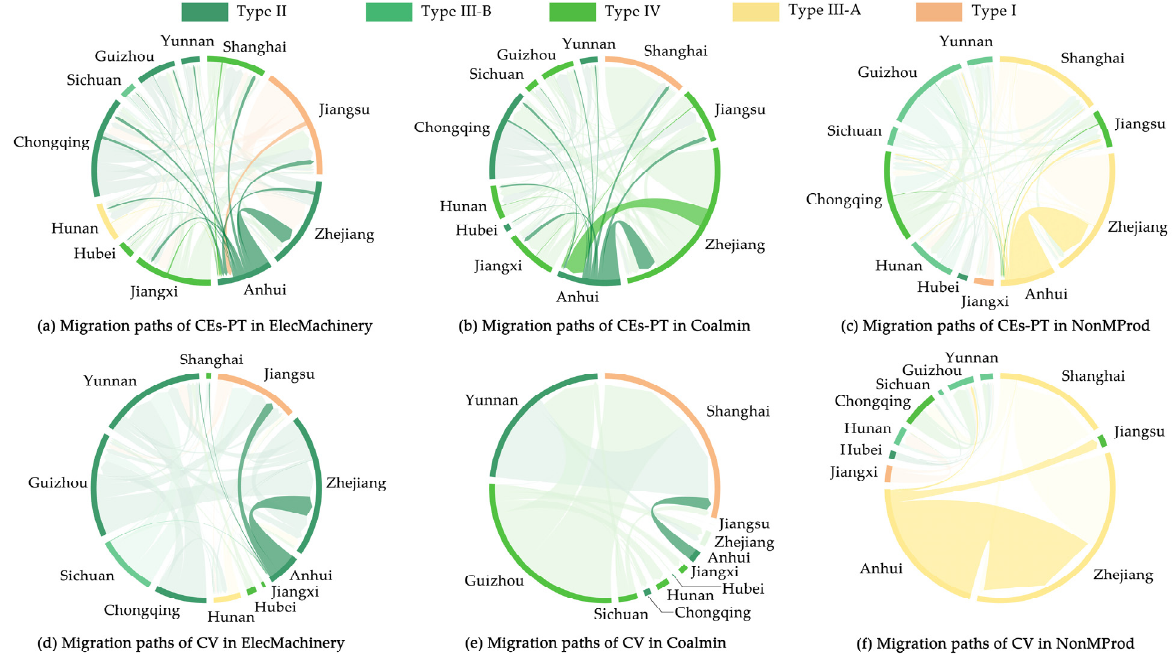
Figure 10. Migration paths of ECEs-IPT and CV in major industry sectors in Anhui among the YREB in 2017.